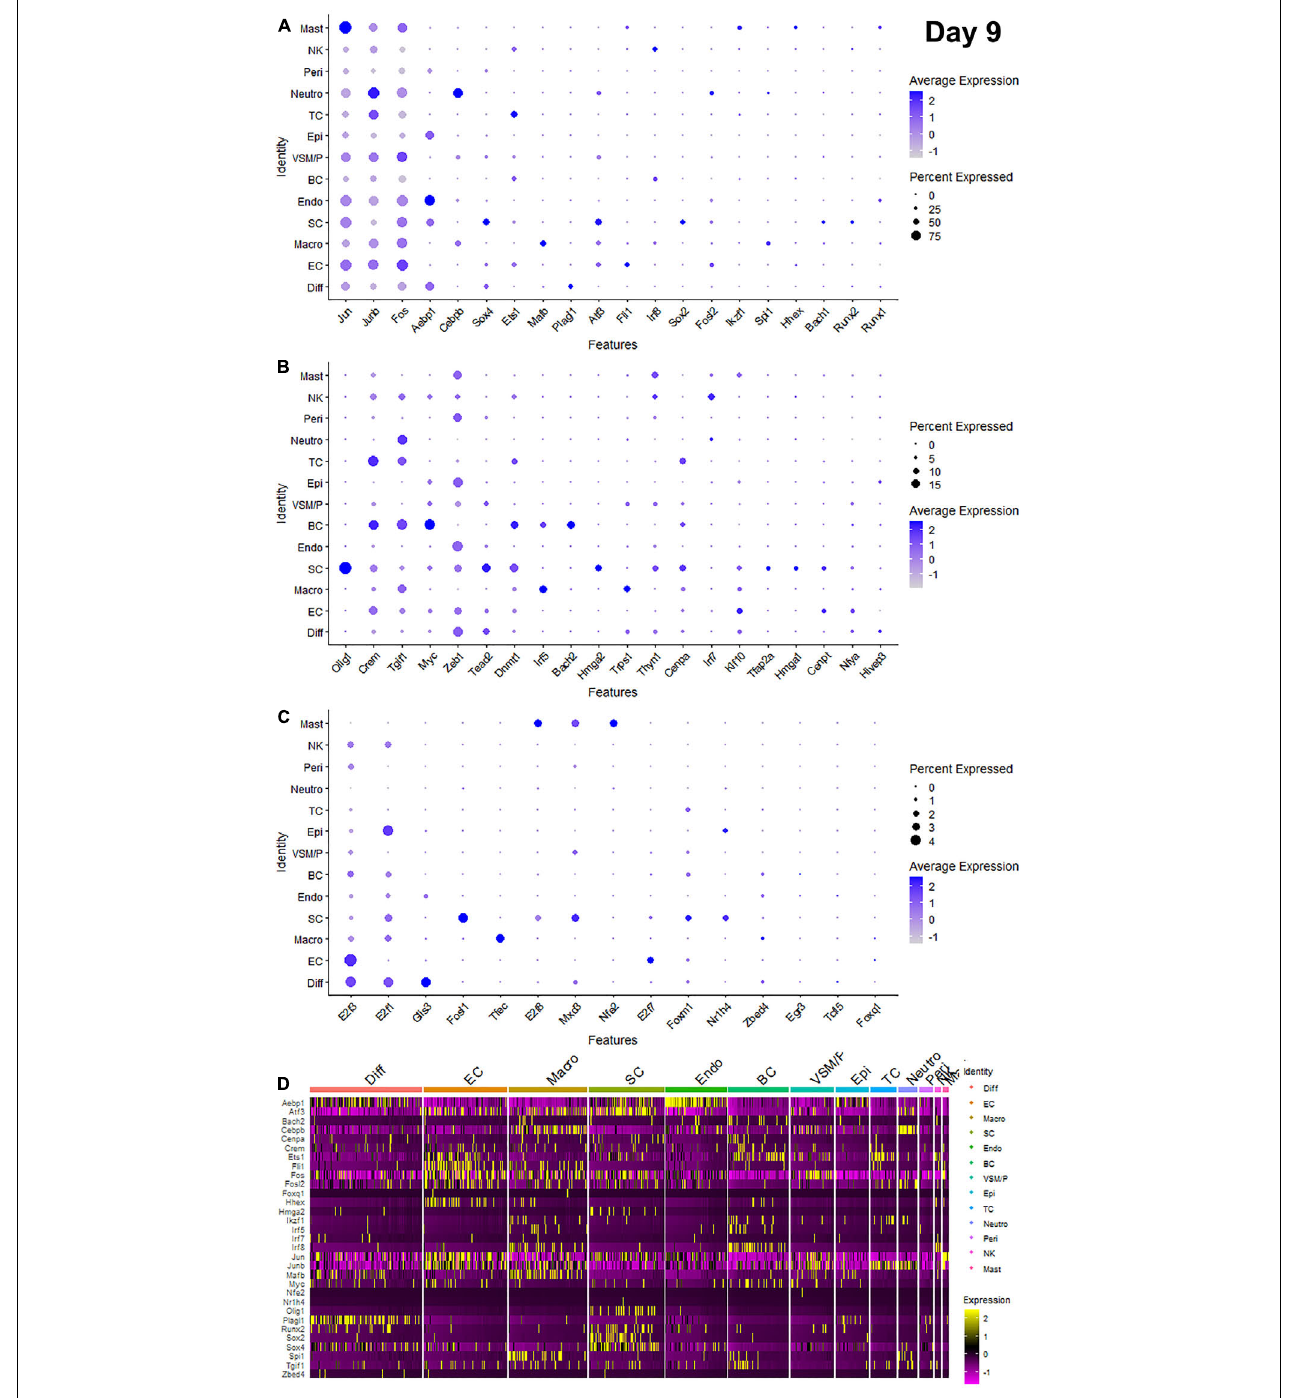
FIGURE 3 | Dotplots and heatmap showing 55 TFs that are up-regulated in the distal nerve at day 9 post-injury. (A) Dotplots for Jun, Junb, Fos, Aebp1, Cebpb, Sox4, Ets1, Mafb, Plagl1, Atf3, Fli1, Irf8, Sox2, Fosl2, Ikzf1, Spi1, Hhex, Bach1, Runx2, and Runx1 which have more than 20% expression at least in one cell cluster. (B) Dotplots for Olig1, Crem, Tgif1, Myc, Zeb1, Tead2, Dnmt1, Irf5, Bach2, Hmga2, Trps1, Thyn1, Cenpa, Irf7, Klf10, Tfap2a, Hmga1, Cenpt, Nfya, and Hivep3 which have expression between 5 and 20% at least in one cell cluster. (C) Dotplots for E2f3, E2f1, Glis3, Fosl1, Tfec, E2f8, Mxd3, Nfe2, E2f7, Foxm1, Nr1h4, Zbed4, Egr3, Tcfl5, and Foxq1 which have expression below 5% in any cell cluster. (D) Heatmap for Aebp1, Atf3, Bach2, Cebpb, Cenpa, Crem, Ets1, Fli1, Fos, Fosl2, Foxq1, Hhex, Hmga2, Ikzf1, Irf5, Irf7, Irf8, Jun, Junb, Mafb, Myc, Nfe2, Nr1h4, Olig1, Plagl1, Runx2, Sox2, Sox4, Spi1, Tgif1, and Zbed4. Diff: Differentiating fibroblasts; Endo: Endoneurial fibroblasts; Peri: Perineurial fibroblasts; Epi: Epineurial fibroblasts; SC: Schwann cells; EC: Endothelial cells; VSM/P: Vascular smooth muscle cells and pericytes; Neutro: Neutrophils; Macro: Macrophages; BC: B cells; TC: T cells; NK: NK cells; and Mast: mast cells.